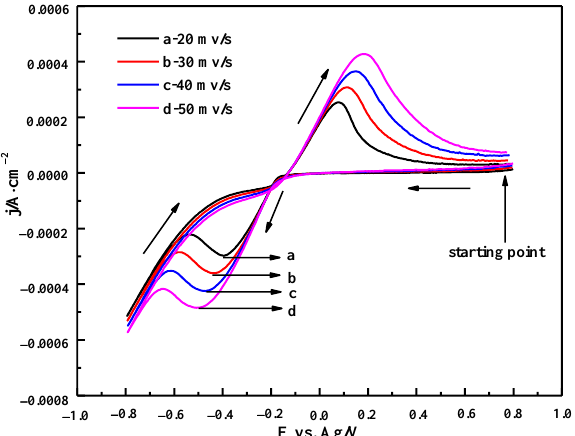
Figure 9. Cyclic voltammetry curves of ChCl-MA-BiCl 3 at different scan rates (T = 343 K, c(BiCl 3 )) = 0.10 M).